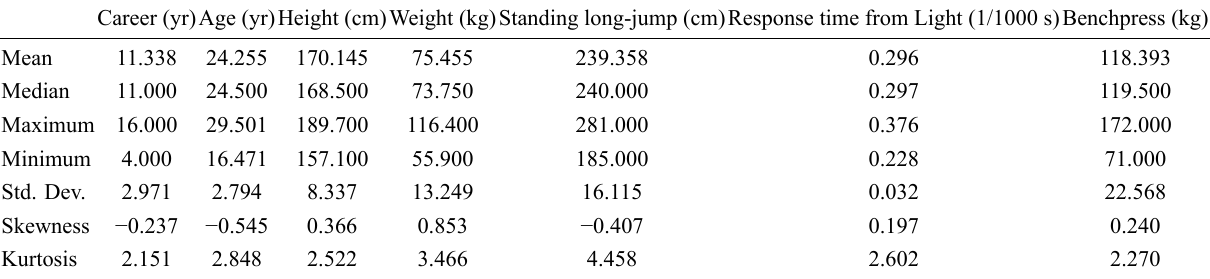
Table 1. Descriptive statistics of factors. This table shows the descriptive statistics of the dataset (n = 74).